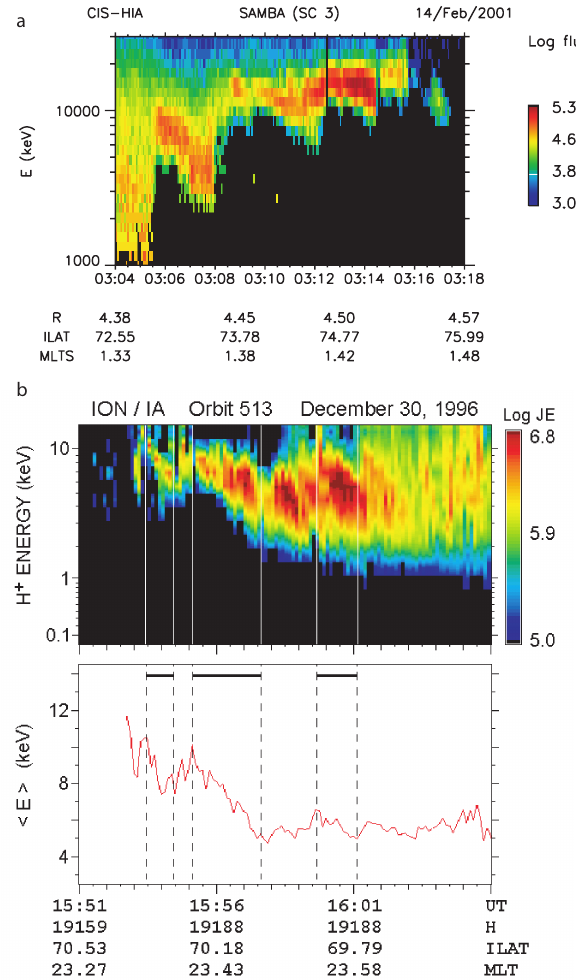
Fig. 24. (a) Example of a high energy VDIS structure measured on board Cluster during a poleward crossing of the auroral zone-polar cap boundary. VDIS consists of substructures where high-energy protons arrive first and the time-of-flight effect of protons gener- ally dominates over the velocity filter effect. (b) Another example of a VDIS structure shown in proton energy-time spectrogram (top panel) and average energy (bottom panel) on board Interball Auroral during an equatorward crossing. The ion average energy decreases in time, while it contains substructures in which higher-energy pro- tons arrive before the low-energy ones as expected from a timeof- flight dispersion (From Sauvaud and Kovrazhkin,